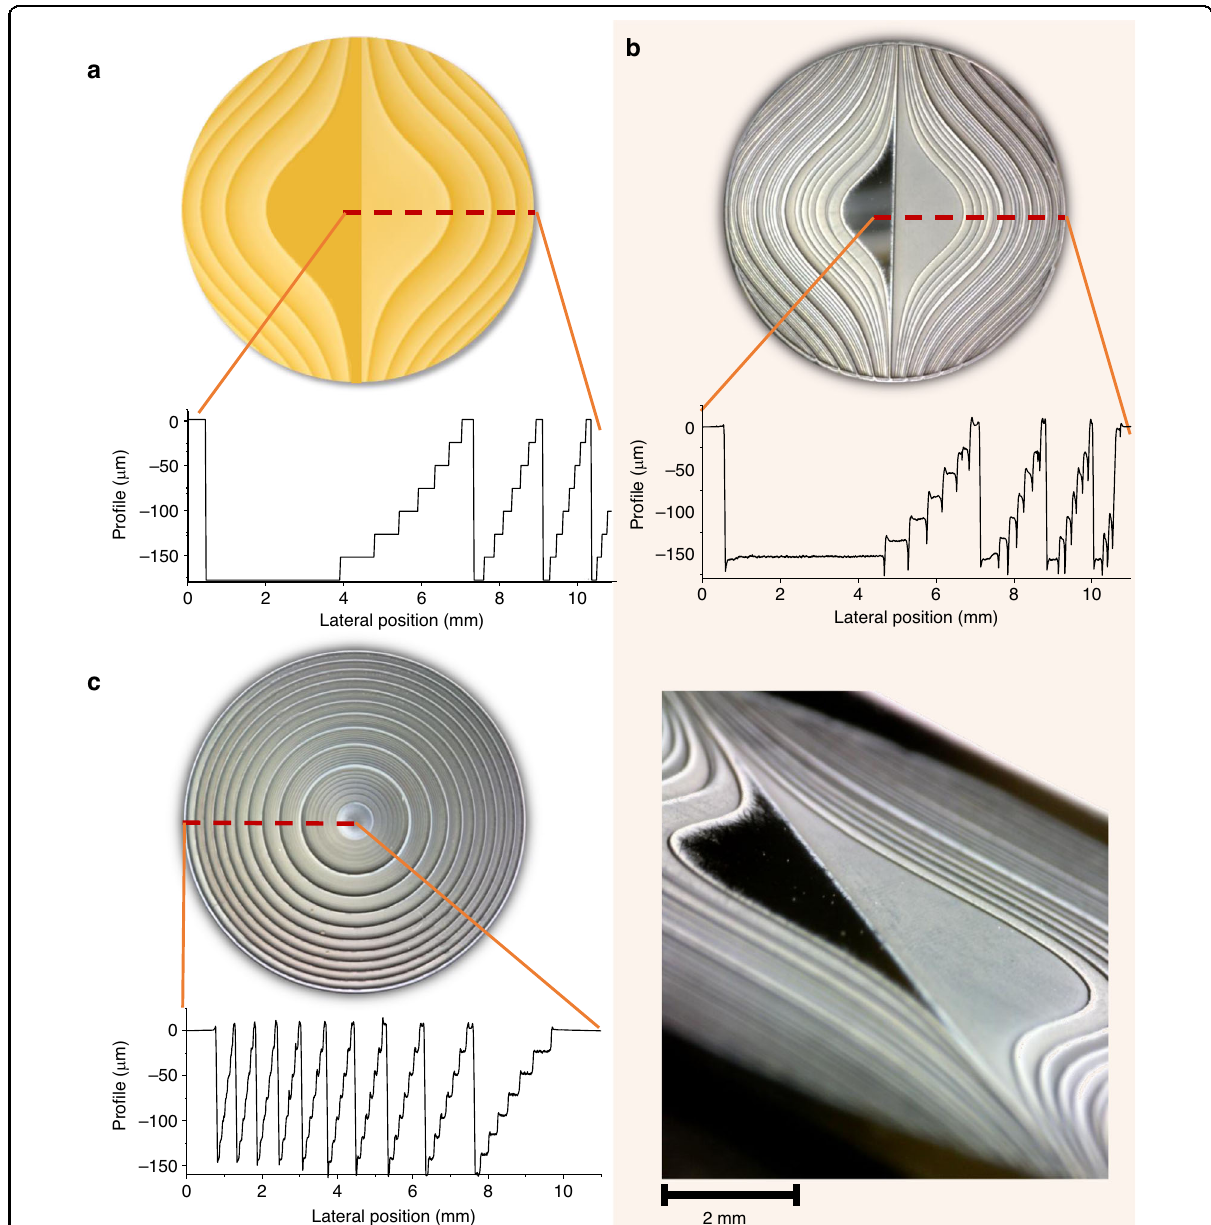
Fig. 1 Designs of photonic elements under study. Spatial distribution of a designed nonparaxial Airy mask and its lateral cross-section; b fabricated silicon nonparaxial Airy element and its cross-section with the enlarged surface structure (bottom panel); c fabricated nonparaxial silicon zone plate with quadratic phase pro fi le and its